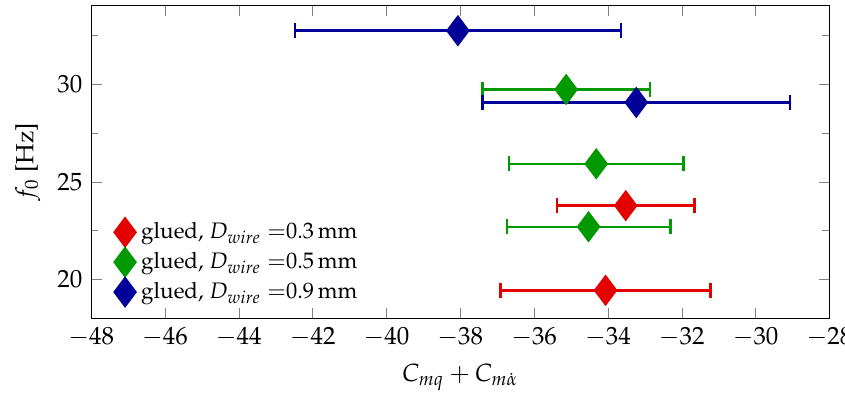
Figure 15. Oscillation frequency over C mq + C m ˙ α at Mach